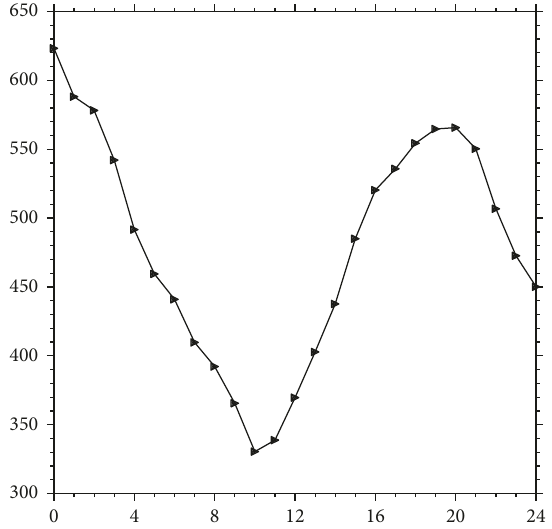
Figure 11: Temporal evolution of vertically integrated water vapor 1 1 ) from surface to 850hPa averaged over m s flux (unit: g kg · · · (113 ° –118 ° E, 28 ° 30 ° N). X -axis indicates the forecasting time 0– − − 24h from 0000 UTC 4–0000 UTC 5 July 2014. −